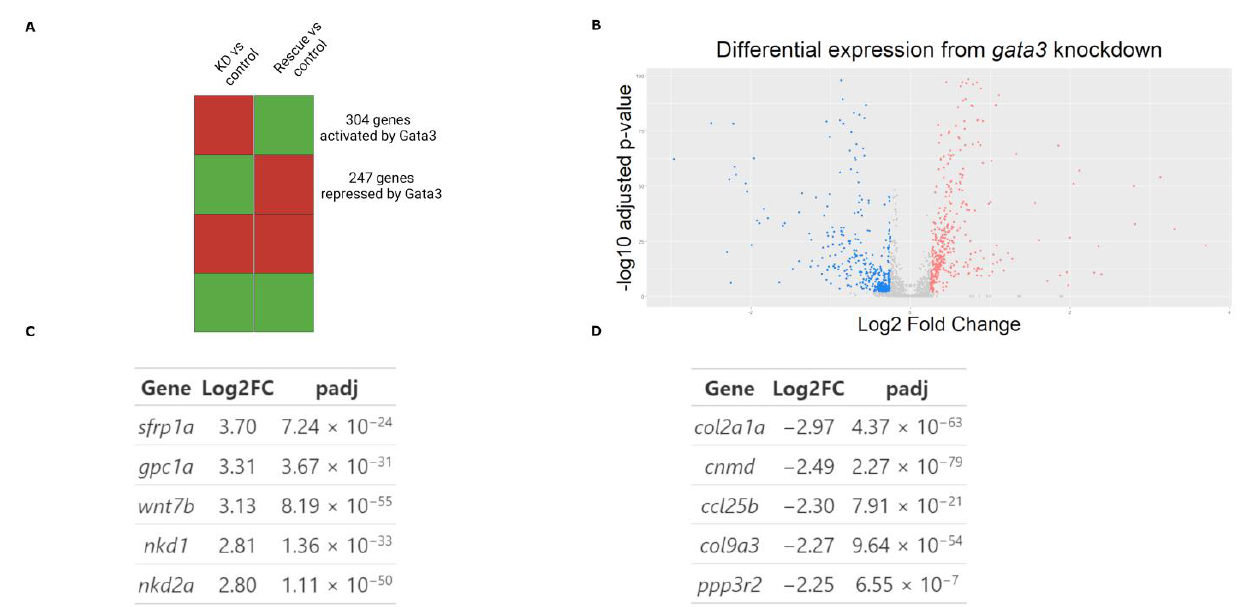
Figure 1. Experimental protocol for RNA-seq. Created with BioRender.com (accessed on 21 No- vember 2022).